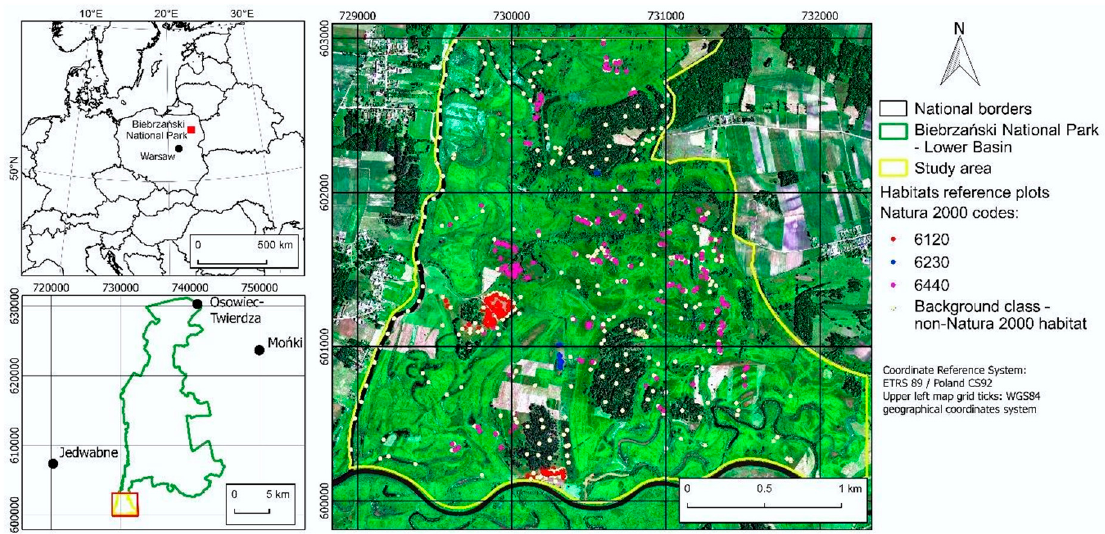
Figure 1 . Study Area, Lower Biebrza, Poland. Figure 1. Study Area, Lower Biebrza,